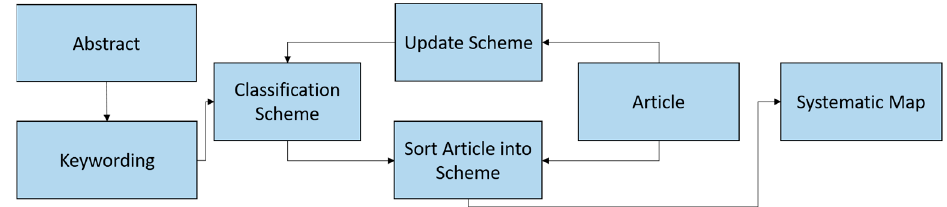
Figure 4. Paper classification process.